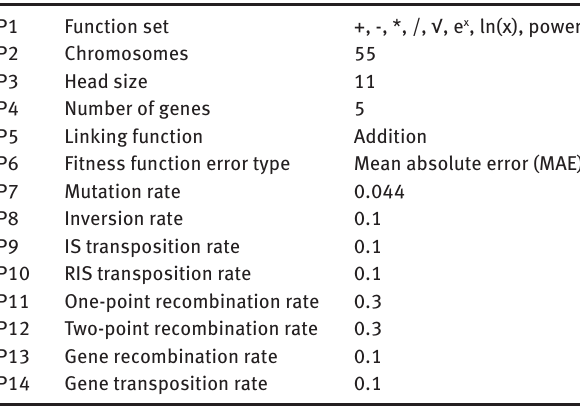
Table 5 Parameters of the GP